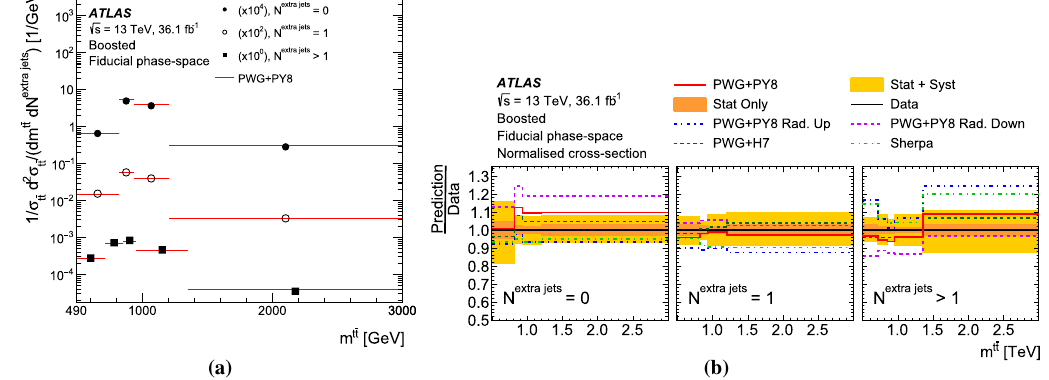
Fig. 51 a Particle-levelnormaliseddifferentialcross-sectionasafunc- tion of the p T of the t ¯ t system in bins of the number of additional jets in the boosted topology compared with the prediction obtained with the Powheg + Pythia8 MC generator. Data points are placed at the cen-